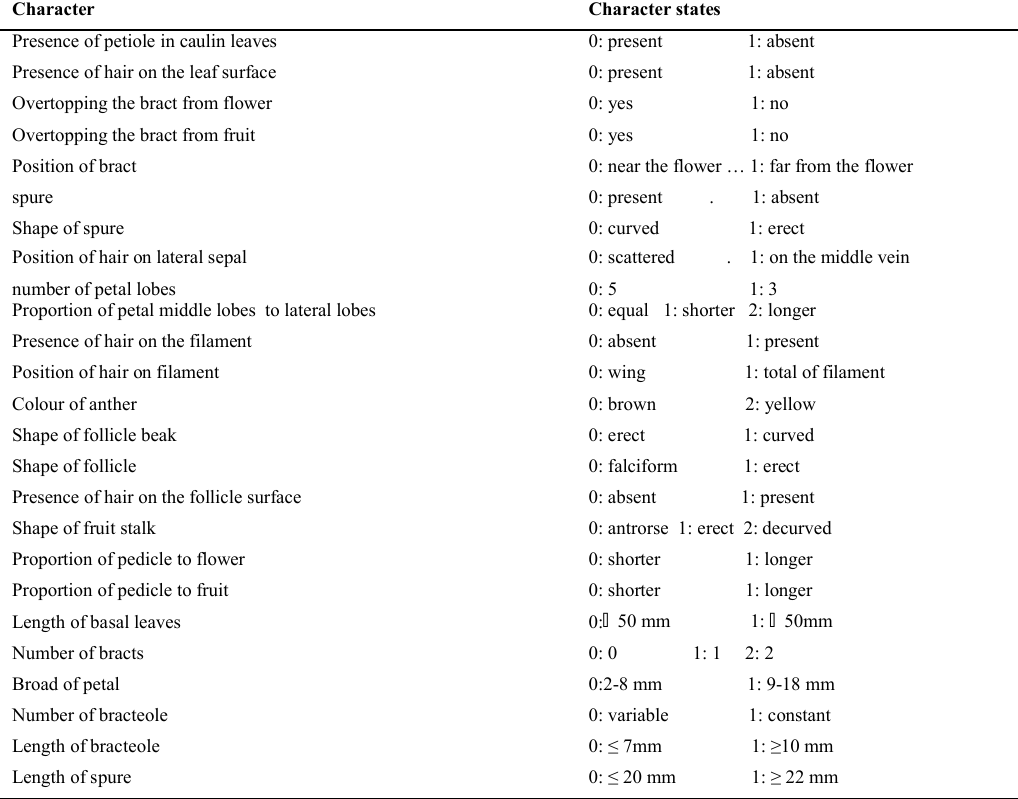
Table 3. Characters used in phenetic analysis